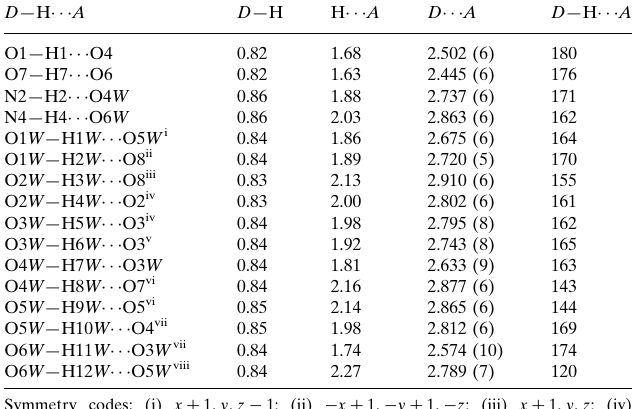
Hydrogen-bond geometry (A˚ , (cid:3)